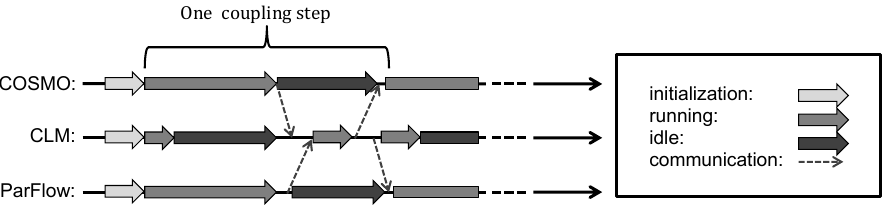
Figure 2. Schematic of the synchronization and communication structure. CLM receives first from COSMO before receiving from ParFlow; thus, wait states in ParFlow are indicating an overloaded COSMO. CLM calculation is very fast, but COSMO and ParFlow are idle during this time. CLM sends first to COSMO before sending to ParFlow. CLM is idle during COSMO and ParFlow